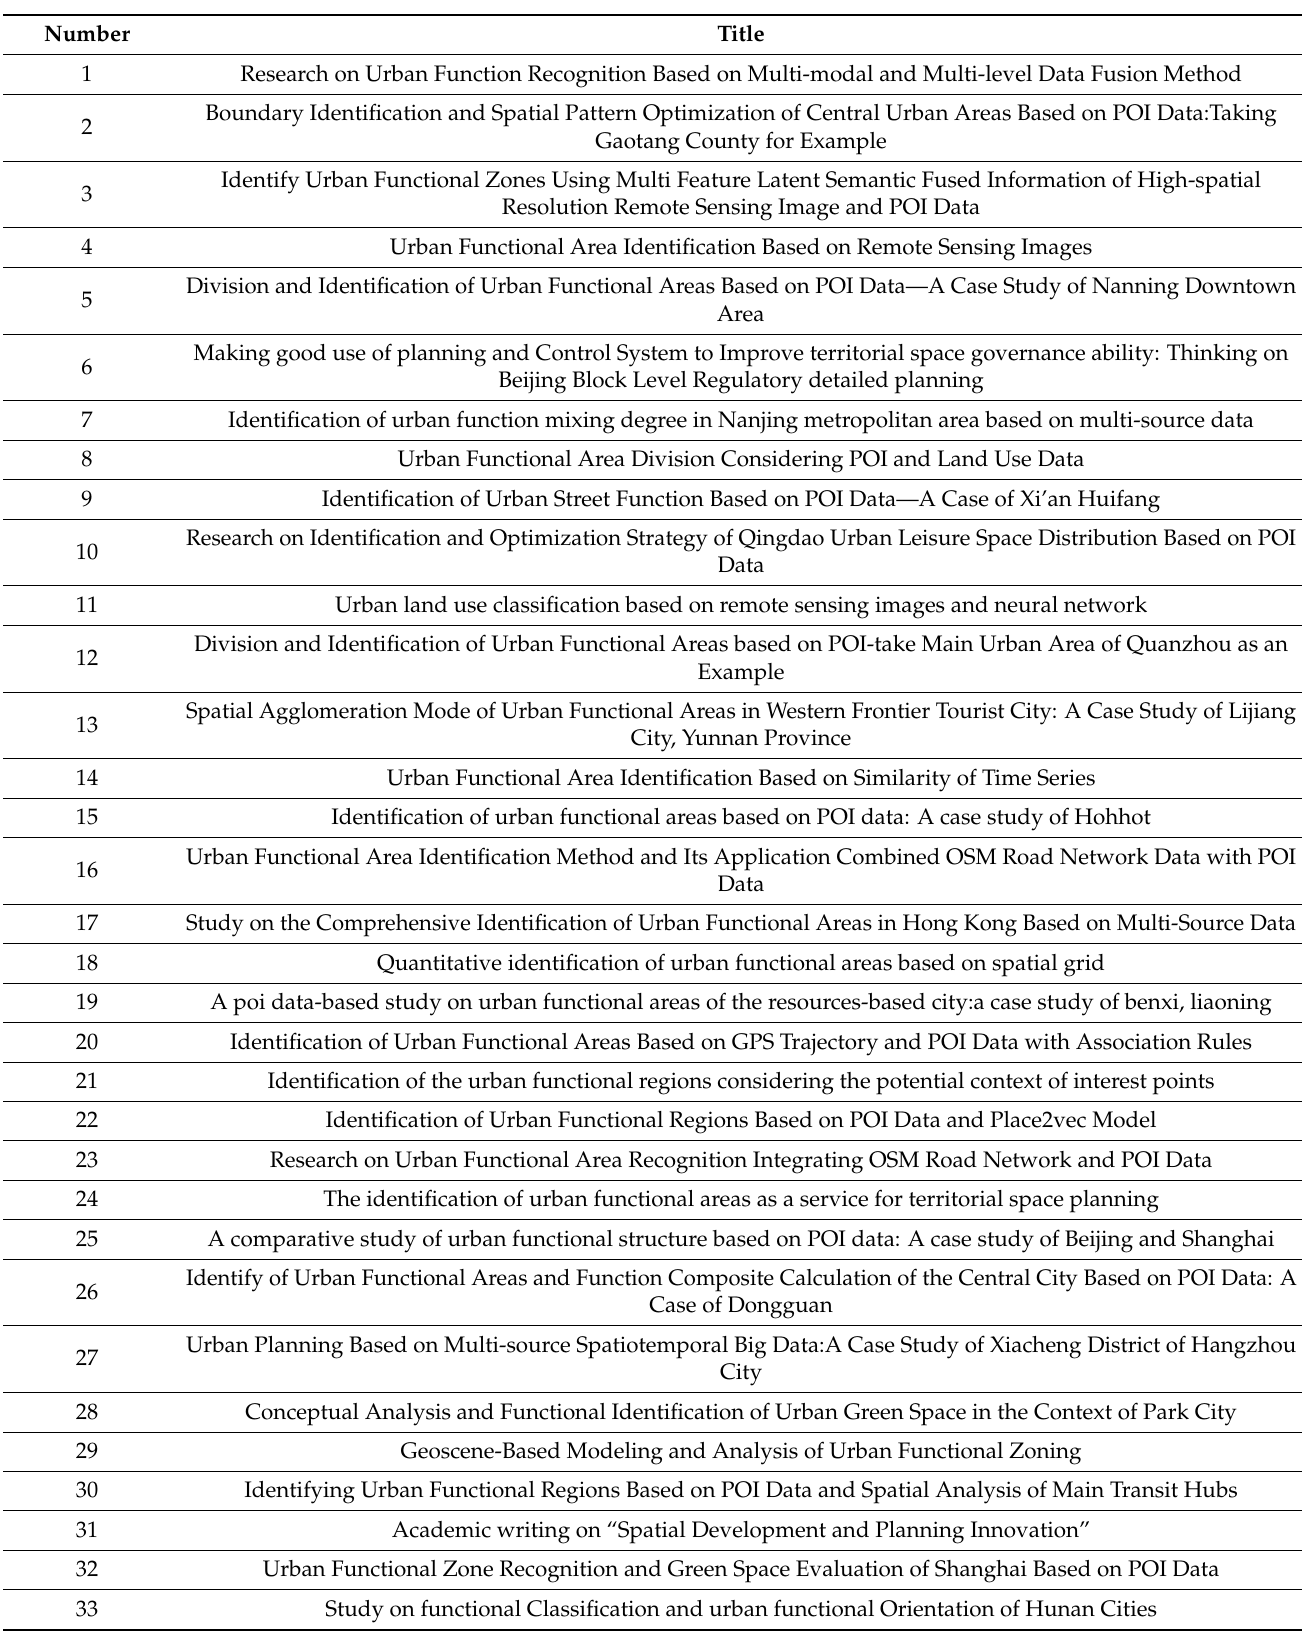
Table A3. List of papers obtained from CNKI